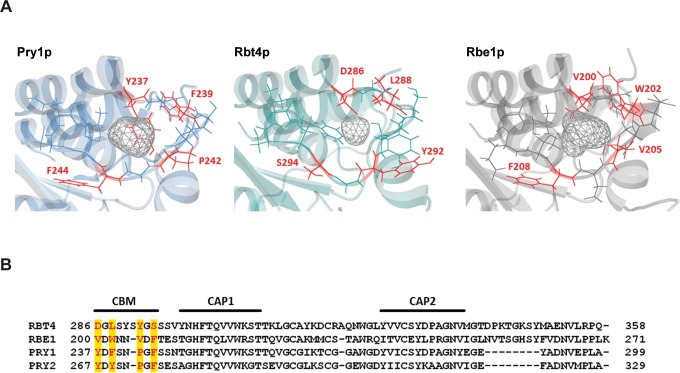
Sequential and structural comparison between different sterol binding domains.(A) 3D model showing the C-terminus of Rbe1p, Rbt4p and Pry1p. Homology models for Rbe1p and Rbt4p were created using the web-based I-Tasser server, while the Pry1p structure represents PBD entry 5ete. Residues forming the cholesterol binding cavity are shown as sticks and CBM residues are additionally colored in red. (B) Multiple sequence alignment containing the C-terminal residues, including the CBM and CAP1/CAP2 motifs, of Rbe1p (C. albicans), Rbt4p (C. albicans), Pry1p (S. cerevisiae) and Pry2p (S. cerevisiae). Residues of the CBM are shown in red.